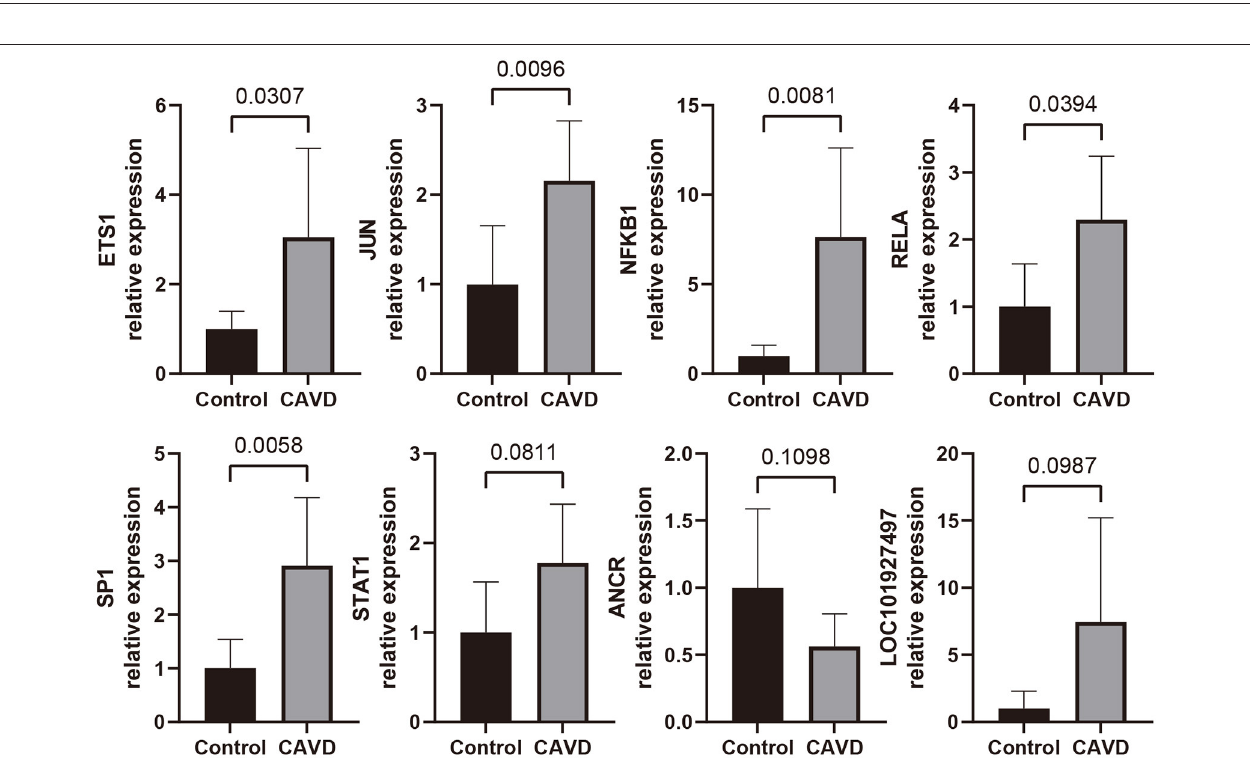
FIGURE 10 | qRT-PCR analyses for expression level of the most promising candidate lncRNAs and TFs in control aortic valves ( n = 6) and CAVD valves ( n = 7).